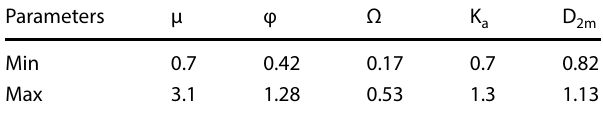
Table 2 Range of the design